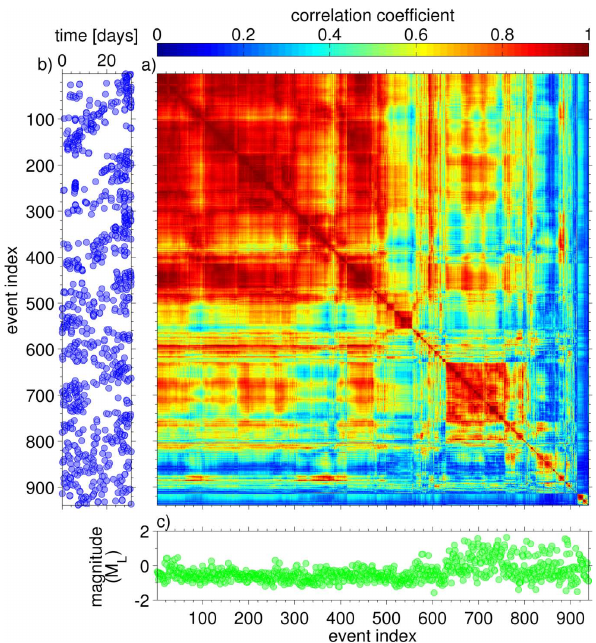
Fig. 4. Sorted similarity matrix (a) for station HM10 and October 2006. (b) and (c) provide additional information about time of oc- currence and magnitude distribution respectively. Sorting of the ma- trix was performed with a value for K of 5. In comparison to Fig. 5, obviously events are not consequently gathered. Instead high simi- larity patterns are fanned out, which is inconvenient for visual clus- ter